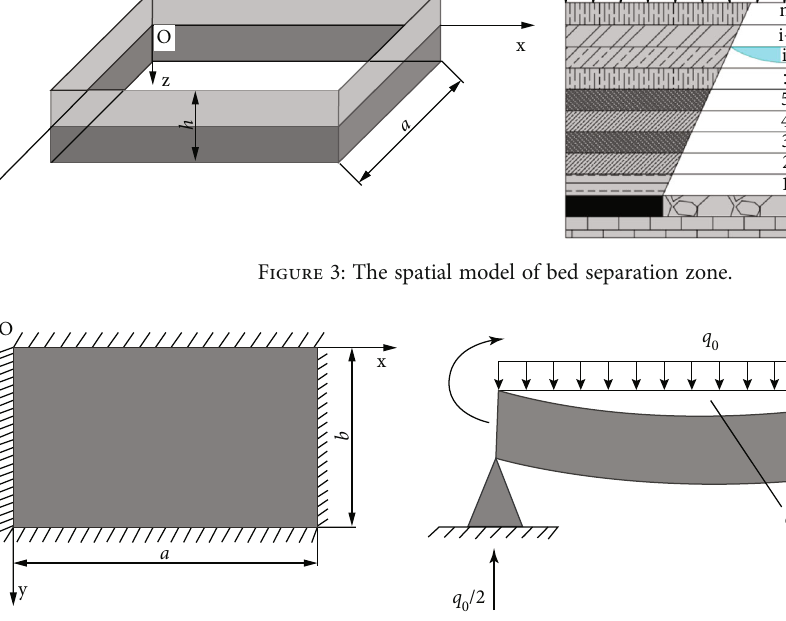
Figure 4: Mechanical model of initial development of bed separation zone under uniform load.